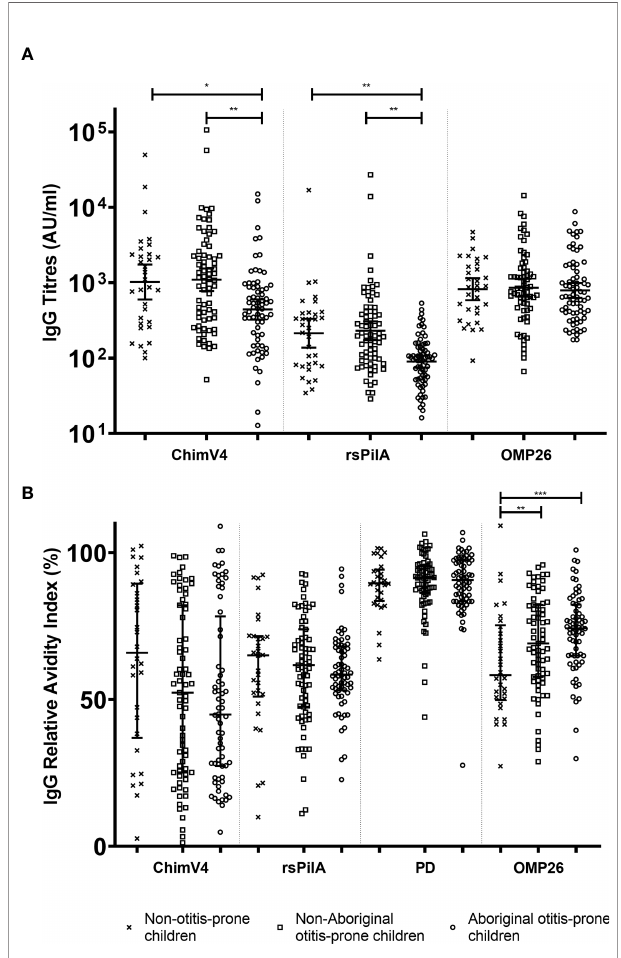
FIGURE 1 | Comparison of serum IgG titres and relative avidity indices between Aboriginal otitis-prone, non-Aboriginal otitis-prone and non- otitis-prone children. (A) Comparison of serum IgG titres between study groups. Levels of serum IgG against NTHi proteins are presented for each individual child, with the horizontal bars depicting the GMC ± 95% CI (not age adjusted). Statistical analyses were conducted on the log transformed GMC data, adjusted for age. (B) Comparison of serum IgG RAI between study groups. RAI serum IgG against NTHi proteins are presented for each individual child, with the horizontal bars depicting the median ± Interquartile Range. ChimV4, chimeric protein V4 (rsPilA+protein 5), rsPilA, recombinant soluble PilA; PD, Protein D; OMP26, outer membrane protein 26. *P ≤ 0.05; **P ≤ 0.01, ***P ≤